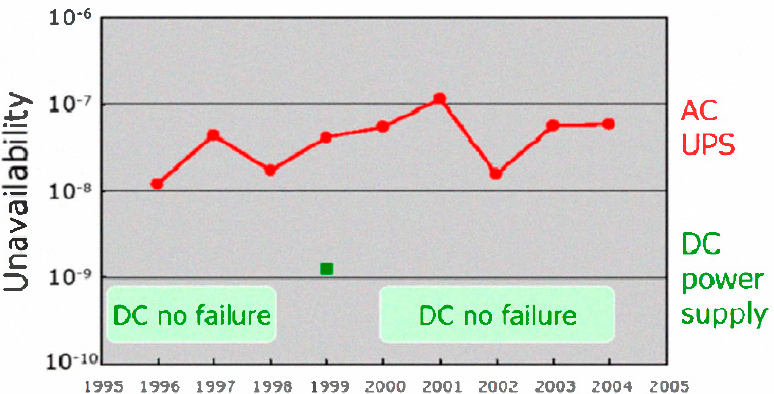
Figure 7. Reliability field data of power systems for 10,000 UPSs and 23,000 DC systems (© of NTT Facilities) [47].